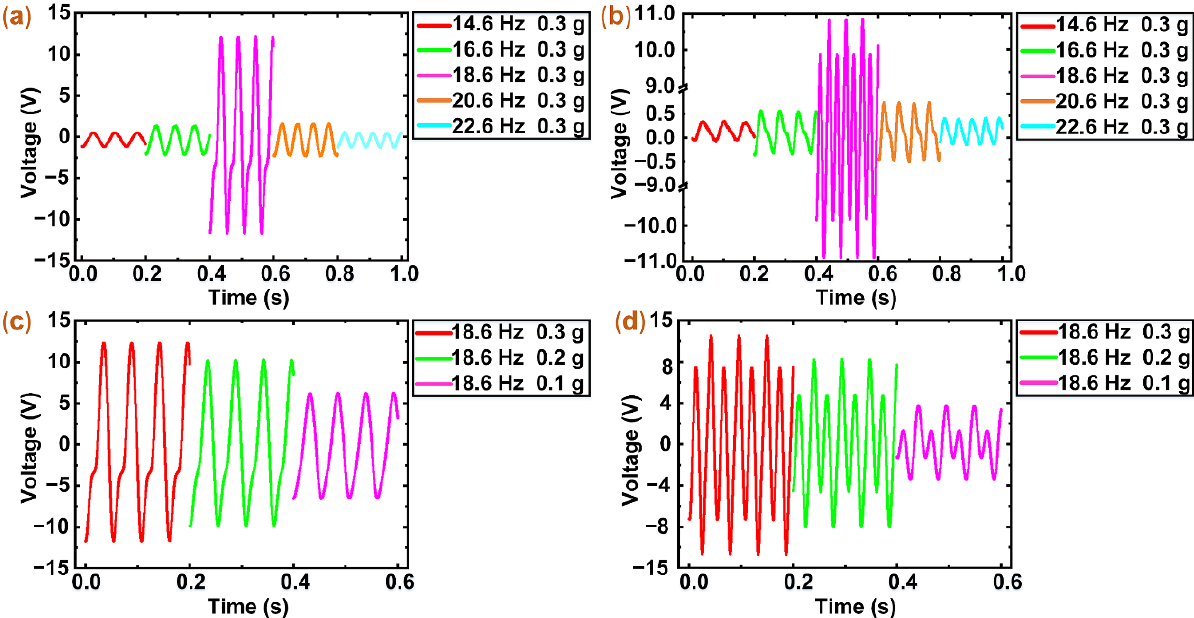
Figure 5. The output voltages of the PEH and EMEH under different frequencies and acceleration. ( a , b ) The output voltages of the PEH and EMEH under different frequencies (14.6 Hz, 16.6 Hz, 18.6 Hz, 20.6 Hz, and 22.6 Hz) and constant acceleration (0.3 g). ( c , d ) The output voltages of the PEH and EMEH under constant frequency (18.6 Hz) and different acceleration (0.1 g, 0.2 g, and 0.3 g).